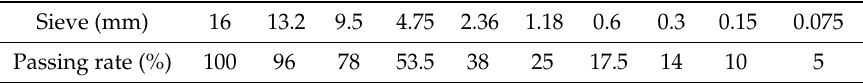
Table 1. Grading of AC-13 asphalt